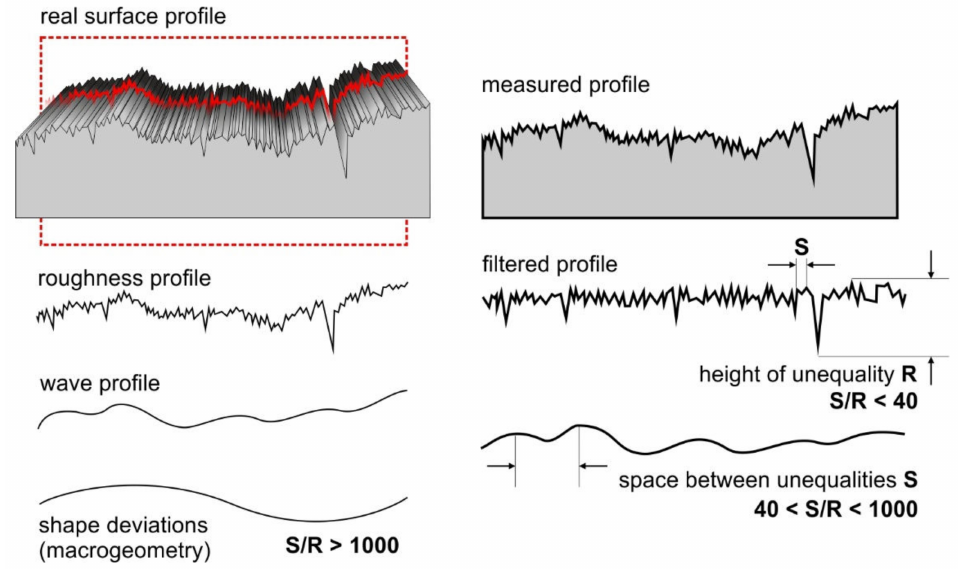
Figure 4. Components of geometric surface structure. S—space between unequalities, R—hight of